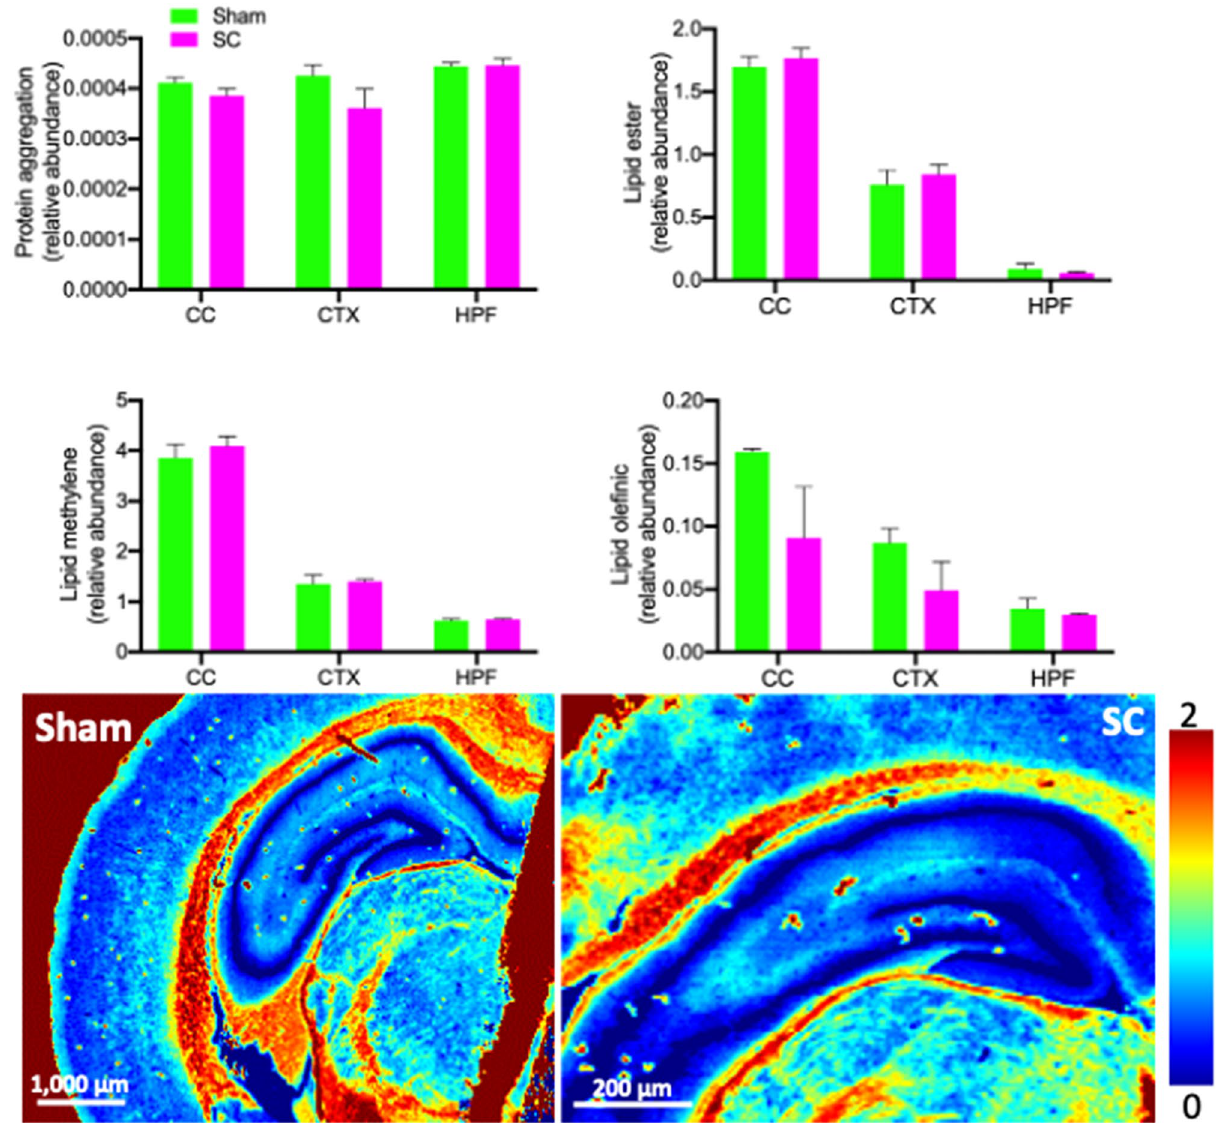
Figure 6. Lipid distribution and protein aggregation in the hippocampal formation and cortex. The changes in the biochemical distribution in the corpus callosum (CC), hippocampus (HPF) and cortex (CTX) of sub- concussion rats (SC) and sham group were analysed with FTIR spectroscopy. The data is shown as the mean relative abundance per area with SEM. Statistical significance was assessed with two-tailed t-test at p < 0.05 (n = 4). Representative spectroscopy images are presented in the lower